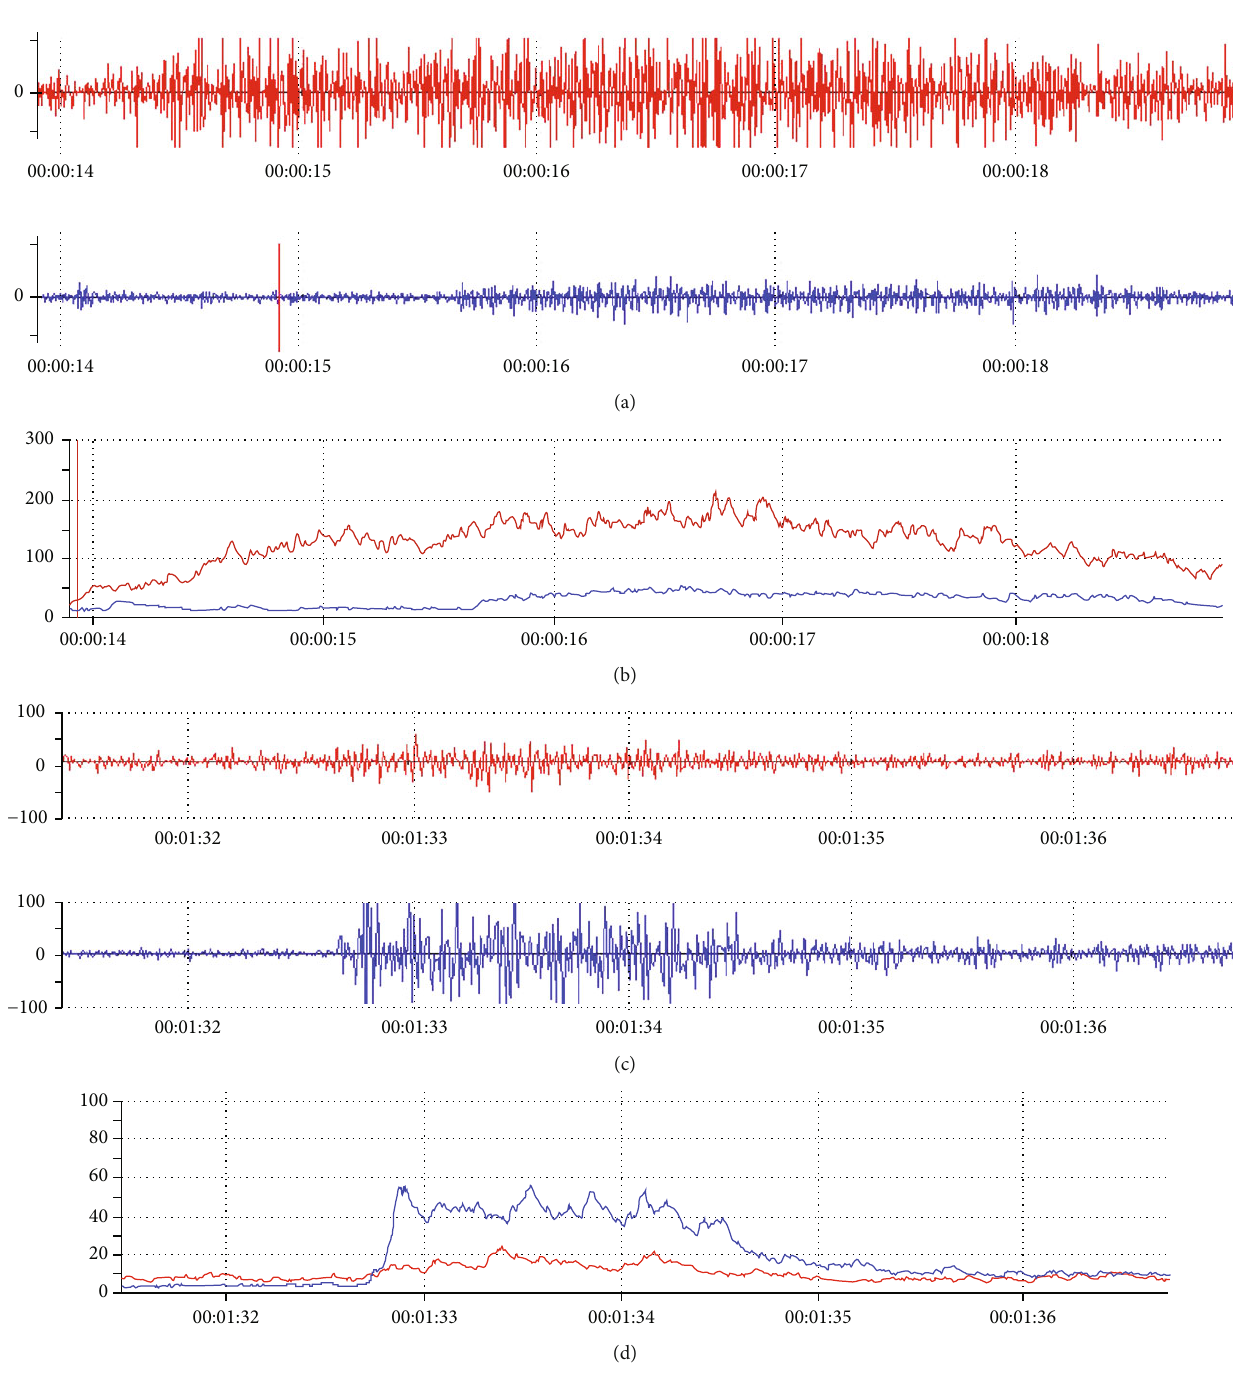
Figure 2: Raw sEMG signals and RMS values of the biceps and brachioradialis during MVIC and FPE on the paretic side. (a) Raw sEMG signals of the biceps brachii and brachioradialis during MVIC. (b) RMS values of the biceps brachii and brachioradialis during MVIC. (c) Raw sEMG signals of the biceps brachii and brachioradialis during FPE. (d) RMS values of the biceps brachii and brachioradialis during FPE. sEMG: surface electromyography. MVIC: maximum voluntary isometriccontraction; FPE: fast passive extension; RMS: root mean square. (red: biceps brachii; blue: